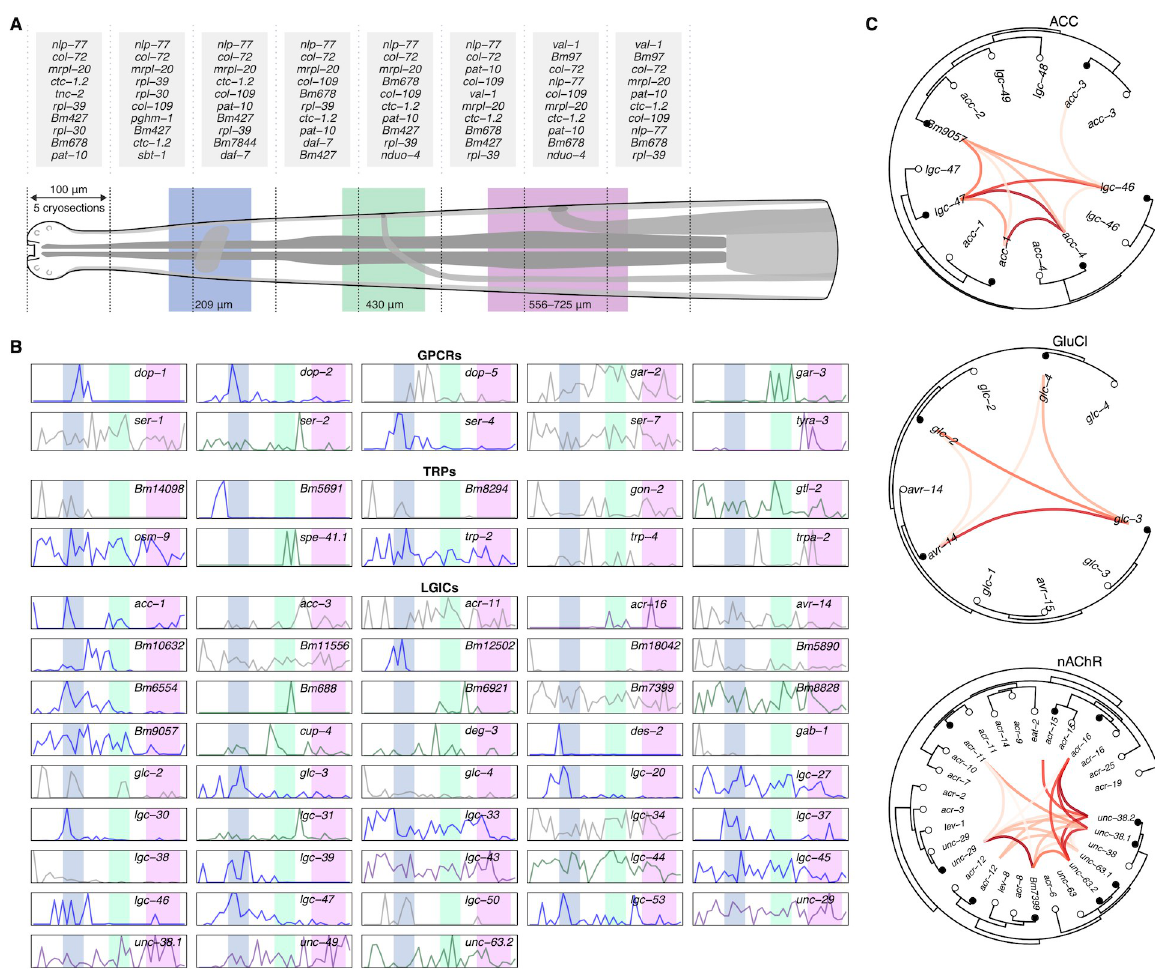
Fig 5. Spatial analyses of highly-expressed genes and putative receptor drug targets. (A) The most-highly expressed genes are shown for each 100 μ m pseudo-section (combining neighboring sets of five 20 μ m cryosections), in relation to the anatomy of the adult female head. The location ranges of major structures reflect worm-to-worm variation: ± 50 μ m for the nerve ring (blue) and ES pore (green), and as empirically determined for the vulva (purple). (B) Spatial patterns of expression for detected genes (TPM > 10 in at least one cryosection) belonging to classically druggable receptor families (GPCRs, TRPs, LGICs) for the highest-quality biological replicate (y-axis = scaled TPM). Line colors signify transcripts that are largely restricted to or are enriched in the vicinity of the matching head structure. (C) Phylogenetic trees showing spatial correlations among cys-loop LGIC subunits belonging to the acetylcholine-gated chloride channel (ACCs, top), glutamate-gated chloride channel (GluCls, middle), and nicotinic acetylcholine receptor (nAChRs, bottom) subfamilies. Links represent the Pearson correlation coefficient (darker color reflects higher correlation, corresponding to S2 Fig), which was calculated from scale-normalized TPM values from the highest-quality RNA tomography replicate; only links with a positive correlation are shown (black points: B . malayi and white points: C . elegans ). ( Fig 6A ). RNA sequencing of intestinal and non-intestinal tissues revealed 1,077 intestine- enriched genes (log (FC) > 1 and p-value < 0.01) with 489 genes predicted to contain at least 2 one transmembrane domain. Among these, 64 putative membrane proteins were further priori- tized as candidate hidden antigens based on high intestinal expression (mean TPM > 100) and relatively low abundance in non-intestinal tissues (intestinal:non-intestinal TPM ratio > 10) ( Fig 6B and S3 Table ). These data greatly expand on the Brugia intestinal proteome [28] and provide new leads that are more likely to be tissue restricted. We identify cathepsin-like protease Bma-cpl-1 as an intestinally-enriched target, along with membrane targets that include a GABA receptor subunit ( Bma-gab-1 ), glutamate transporter ( Bma-gtl-1 ), neuropeptide GPCR ( Bma-